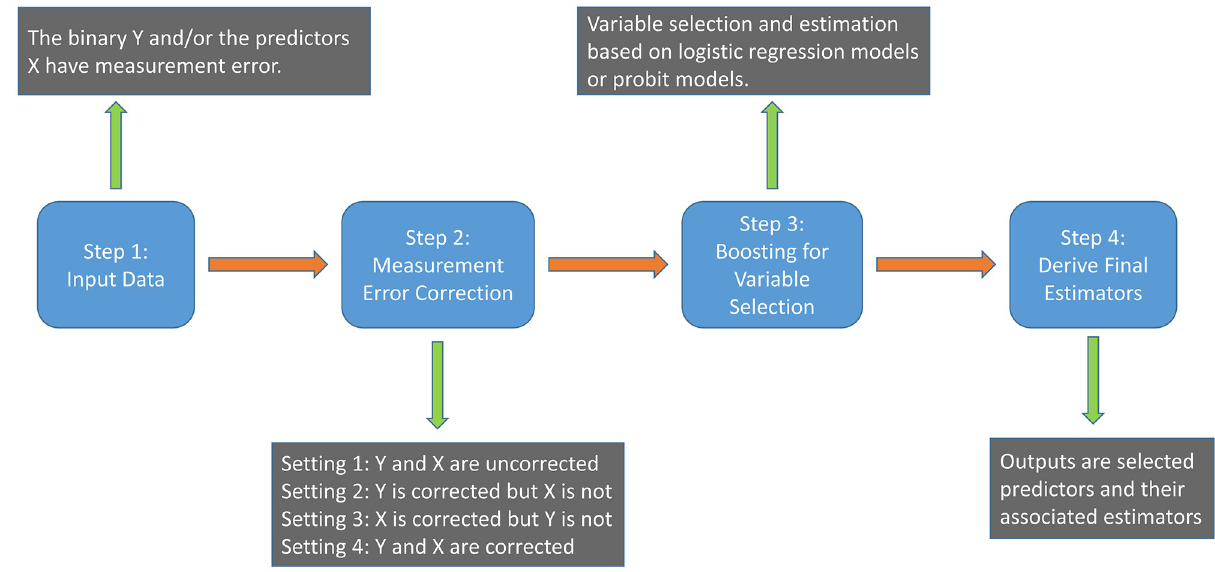
Fig 1. Diagram of data analysis and implementation of the package BOOME